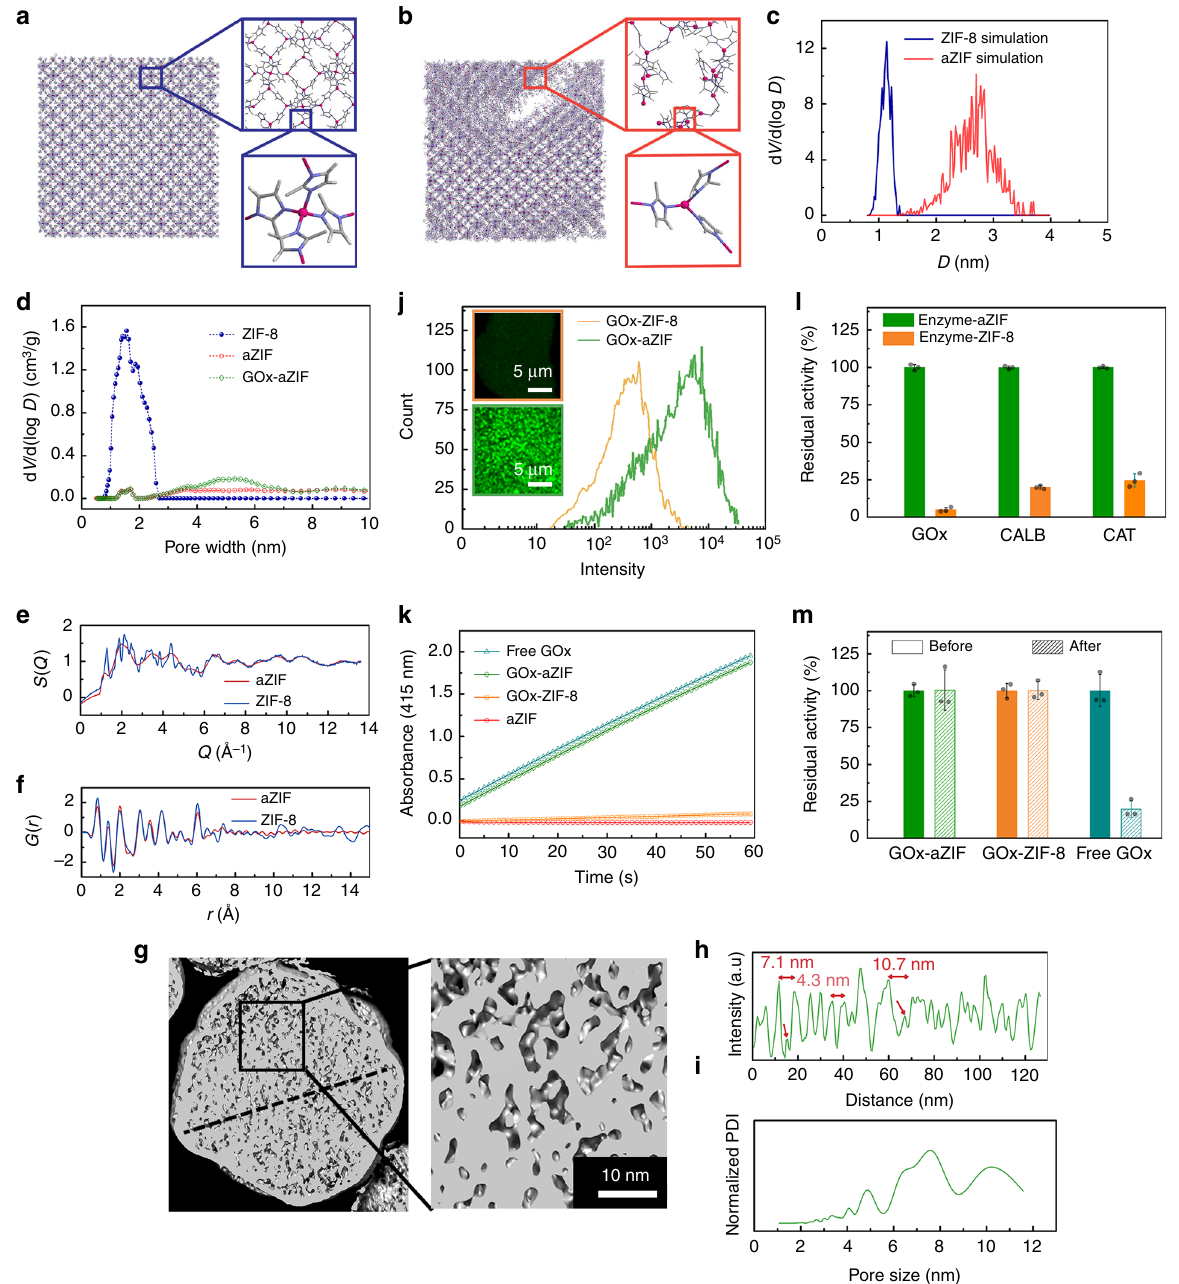
Fig. 2 Coordination defects, mesopores, and activities of enzyme-aZIF nanocomposites. Structures of ZIF-8 ( a ) and aZIF ( b ) by molecular simulations (insets: schemes showing coordination). c Pore size distribution of ZIF-8 and aZIF by molecular simulations. d Density functional theory (DFT) pore size distribution detected with N 2 adsorption and desorption at 77 K for ZIF-8, amorphous ZIF, and GOx-incorporated amorphous ZIF. X-ray total scattering data ( e ) and PDF ( f ) of aZIF and ZIF-8. g Cryo-electron tomography (Cryo-ET) reconstruction and its zoomed image of a single GOx-aZIF nanocomposite. h Linear scan of electron density along the dashed line. Three characteristic pore sizes are shown on the plot, tiny peaks possibly representing the encapsulated enzyme molecules are marked by arrowheads. i Fast Fourier transformation of the electron density linear scan is converted to pore size distribution of the GOx-aZIF in the left panel. Normalized PDI: normalized pore distribution intensity. j Fluorescence intensity of glucose analogs in GOx- ZIF-8 and GOx-aZIF nanocomposites detected via fl ow cytometry. Inset: confocal laser scanning microscopy (CLSM) showing the fl uorescent glucose analog entering the pore of ZIF-8 (up) and amorphous ZIF (down). k Enzymatic reaction kinetics for the oxidation of glucose catalyzed by amorphous ZIF, free GOx, GOx-ZIF-8, and GOx-aZIF nanocomposites. l Enzymatic activities of enzyme-ZIF-8 and enzyme-incorporated amorphous ZIF, including GOx, Candida antartic lipase B (CALB) and catalase (CAT). The activity of corresponding free enzyme was referenced as 100%. Data were represented as mean ± s.d. ( n = 3). m Stability of GOx-aZIF nanocomposites and free GOx against protease digestion under 40 °C for 3 h. Data were represented as mean ± s.d. ( n = 3). Source data are provided as a Source Data fi